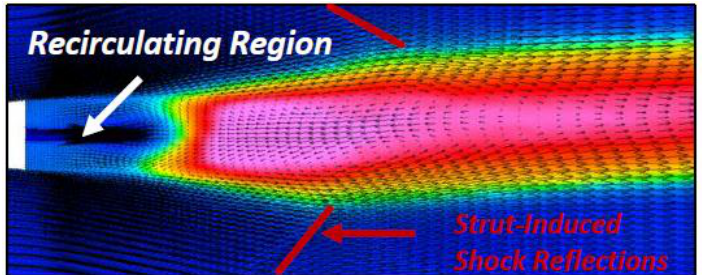
Figure 5. Strut injection study of temperature field and velocity vectors reported in Reference [4].